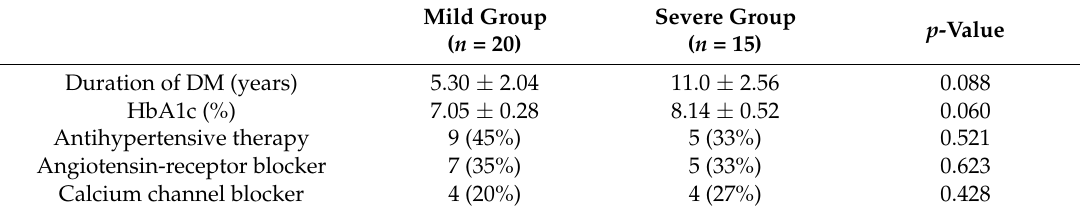
Table 2. Baseline characteristics of